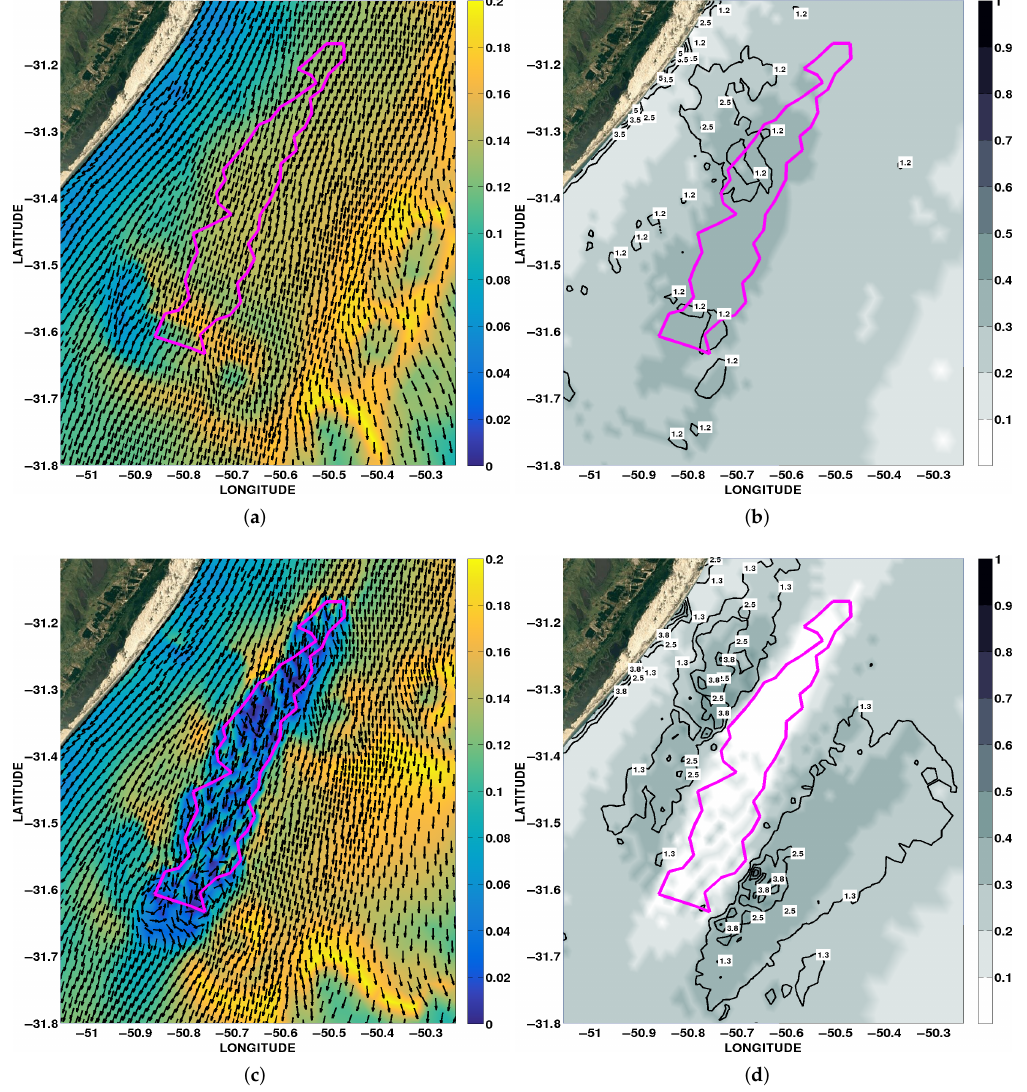
Figure 6. Rio Grande do Sul turbines site. Simulation without the presence of turbines (upper panel) and with the turbines (lower panel), as the sites are represented by the magenta boundary line. ( a , c ) Mean superficial velocity (m · s − 1 ) with mean direction in vectors; ( b , d ) bed shear stress (N · m − 2 ) in black and white colormap with integrated bedload transport (cm 2 · s − 1 ) in black